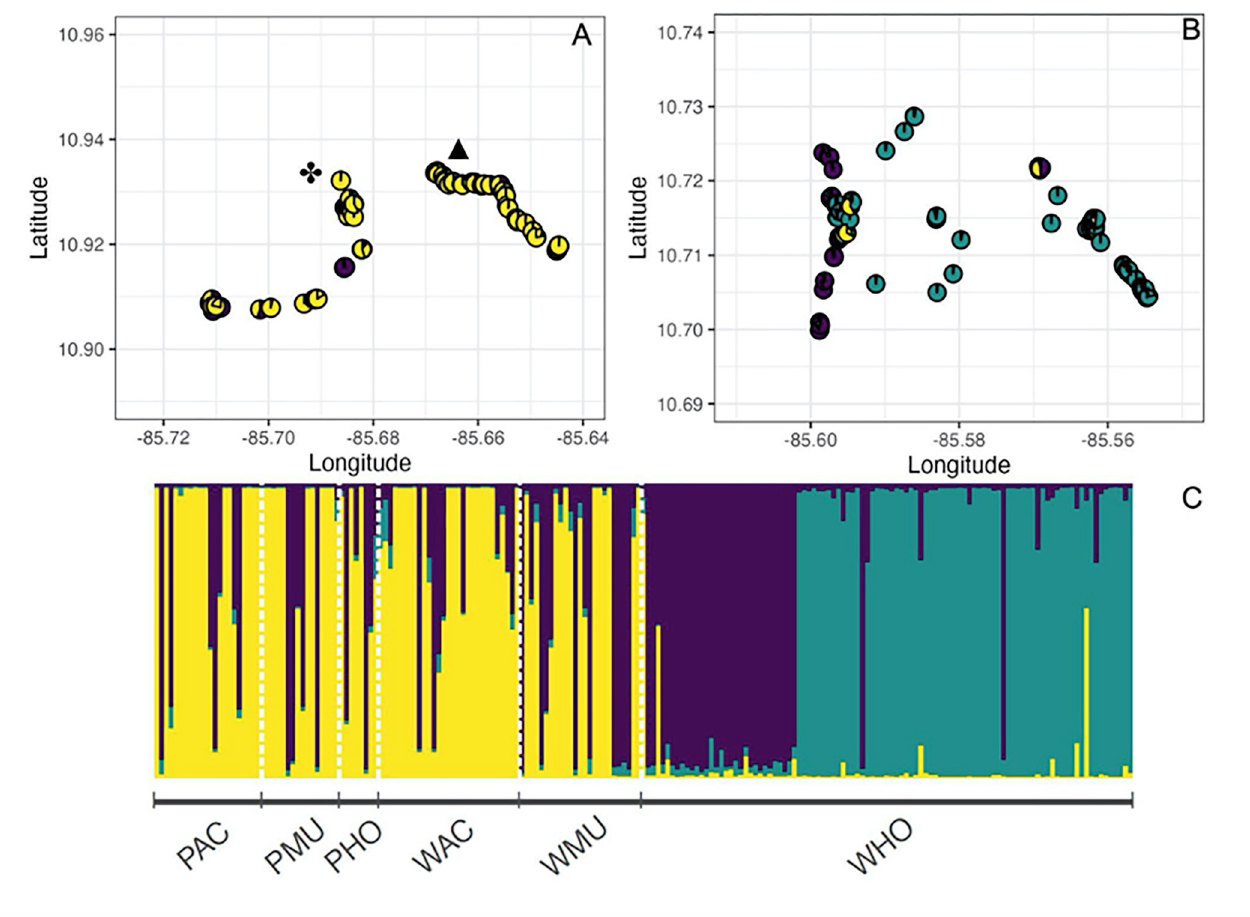
Fig 2. Geographic location of sampled trees within study sites. A) location of trees in Agua Caliente (AC: ✤ ) and Murcie´lago (MU: ▲ ). B) Location of sampled trees and in Horizontes (HO). Pies represent the percentage of each individual cluster assignment to one of three clusters as indicated by STRUCTURE. C) Bayesian assignment performed by STRUCTURE among planted and wild stands of Spondias purpurea in north western Costa Rican for K = 3 clusters. Each vertical bar represents an individual and is divided proportionally to the probability of assignment of each individual to each genetic cluster. Colors in panels A and B are the same as those in panel C. Letters P and W before study site abbreviation indicate Planted and Wild stands, respectively.